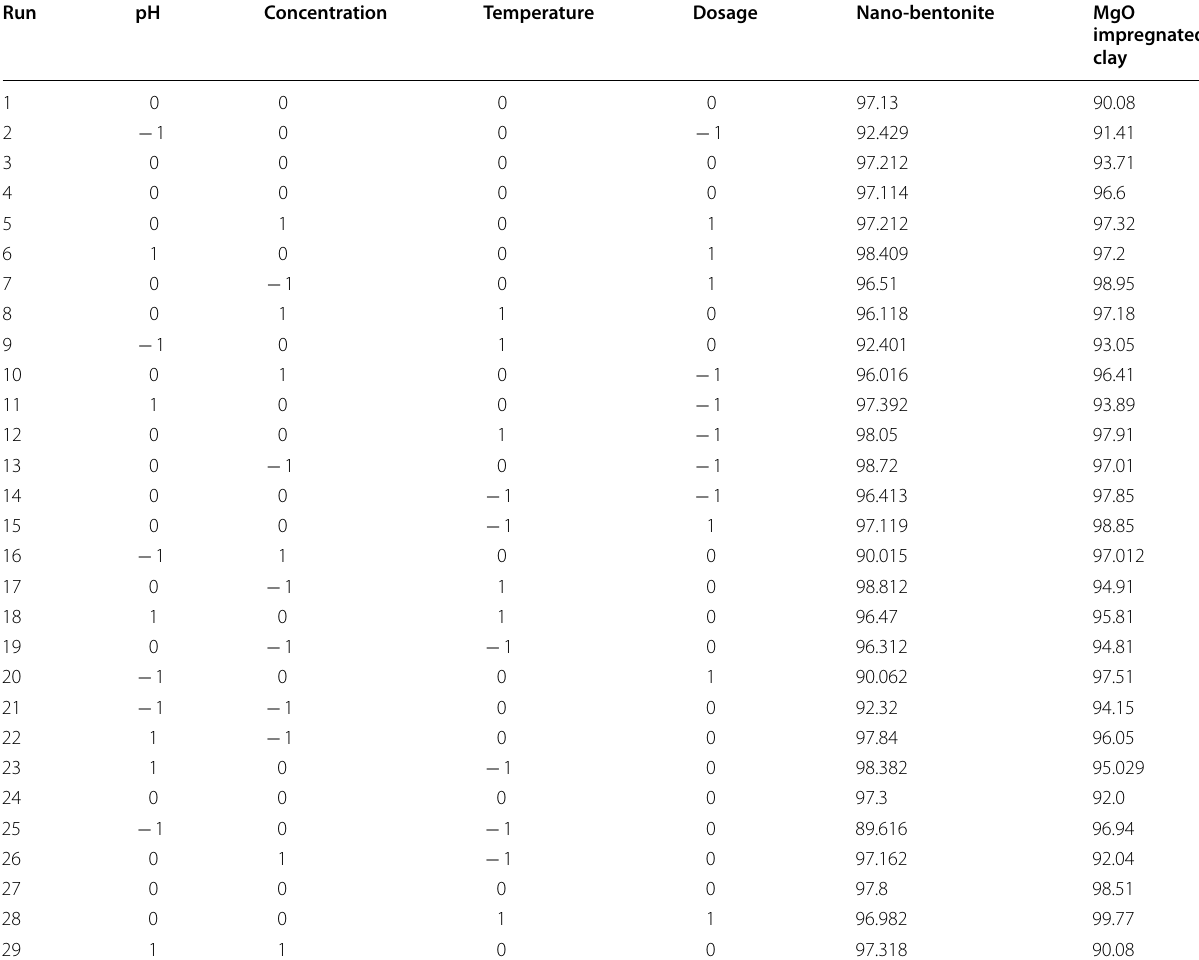
Table 3 Experimental design and results of the Box–Behnken design for the decolourization of MG by nano-bentonite and MgO impregnated